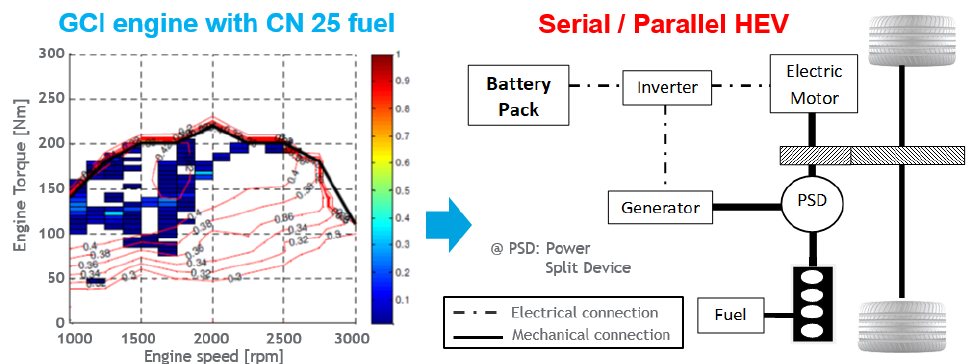
Figure 9. Energy-weighted operating point distribution of CN25 engine on WLTC and serial/Parallel hybrid